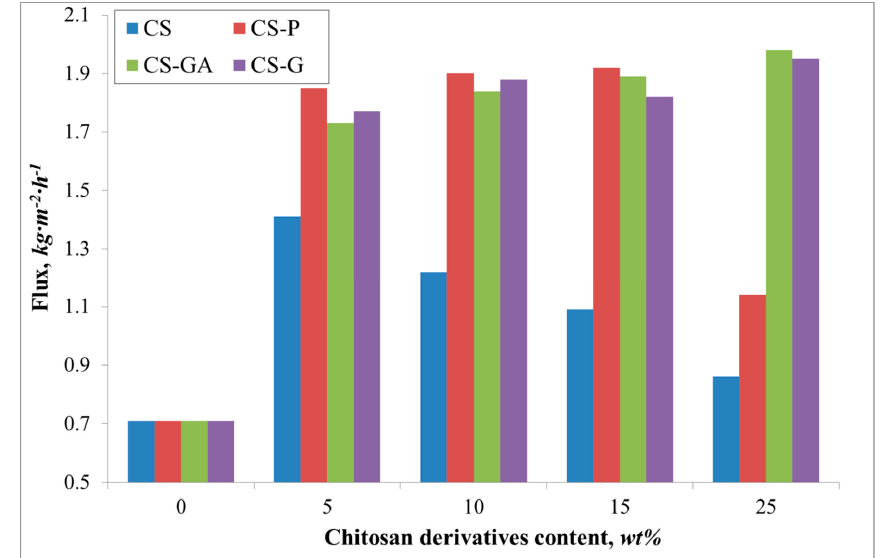
Figure 5. The variation of the measured total fluxes for the Alg membranes with increasing content of chitosan (CS) and modified CS microparticles; phosphorylated chitosan (CS ‐ P), glutaraldehyde crosslinked chitosan (CS ‐ GA), and glycidol ‐ modified chitosan (CS ‐ G).